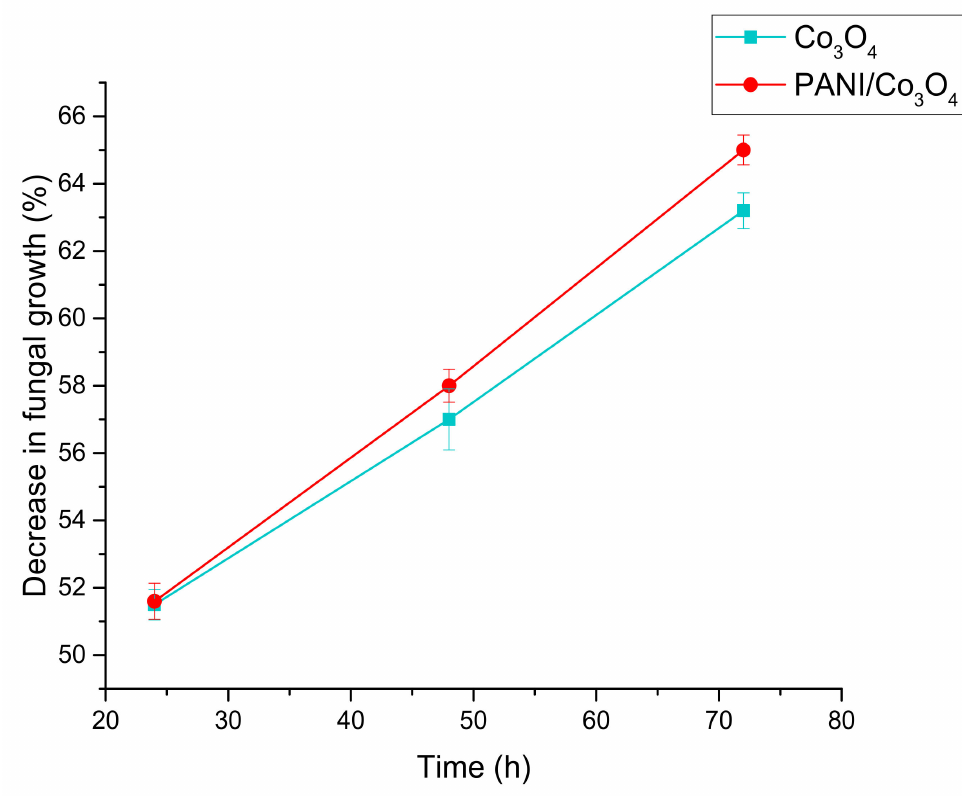
Figure 10. Comparison of the rates of decrease in fungal growth (%) by Co 3 O 4 and PANI/Co 3 O 4 nanoparticles at their 24 mM